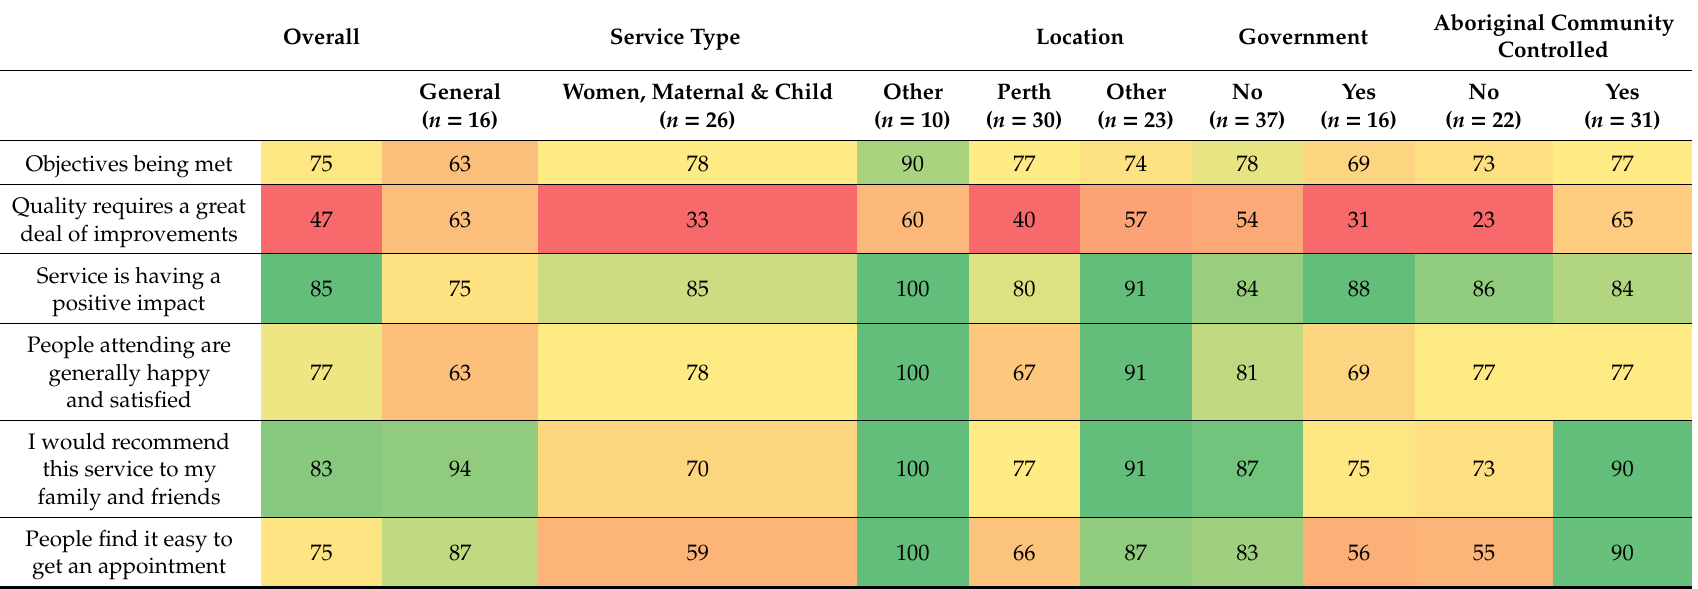
Aboriginal Community Controlled